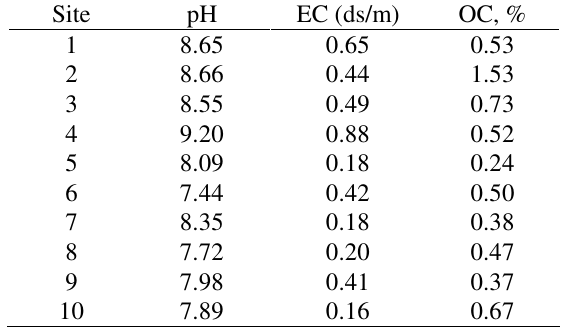
Table 1. Physicochemical properties of soils in roadside soils. (Mean